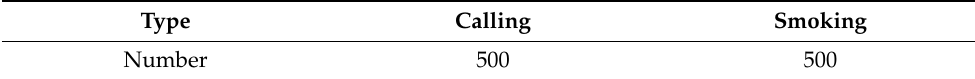
Table 2. Numbers of various types of images.